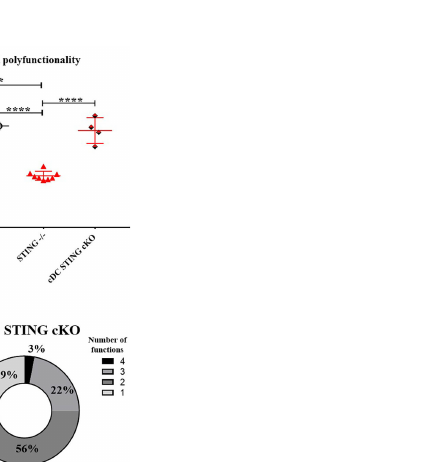
( cDC STING cKO) and cDC STING littermate control ( cDC STING LitC ) mice were IM/EP vaccinated with pNP. Mice were sacri fi ced 21-days post-vacccination and splenocytes collected. (A) Tetramer positive cells within CD8 + T cells were measured for each genotype using a NP immunodominant peptide (NP 366-374 ) containing tetramer as described above and shown in Supplementary Figure 3C . (B) Polyfunctional scores were determined by stimulating splenocytes overnight with 1 m g/ml of NP 366-374 , staining for IL-2, TNF- a , IFN- g and CD107a/GranzymeB and analysis via fl ow cytometry and Boolean gating as shown in Supplementary Figure 4 . Shown are CD8 + T cells ’ polyfunctionality index scores. (C) Pie charts show the relative average proportion of responding CD8 + T cells producing at least one immune function (IL-2, TNF- a , IFN- g and/or CD107a/GranzymeB) after NP 366-374 stimulation. Three independent experiments were performed consisting of 3-9 mice; representative data are the average ±SSD 3-9 mice/genotype. Groups were compared using a one-way ANOVA, ****p < 0.0001, and NS, not signi fi